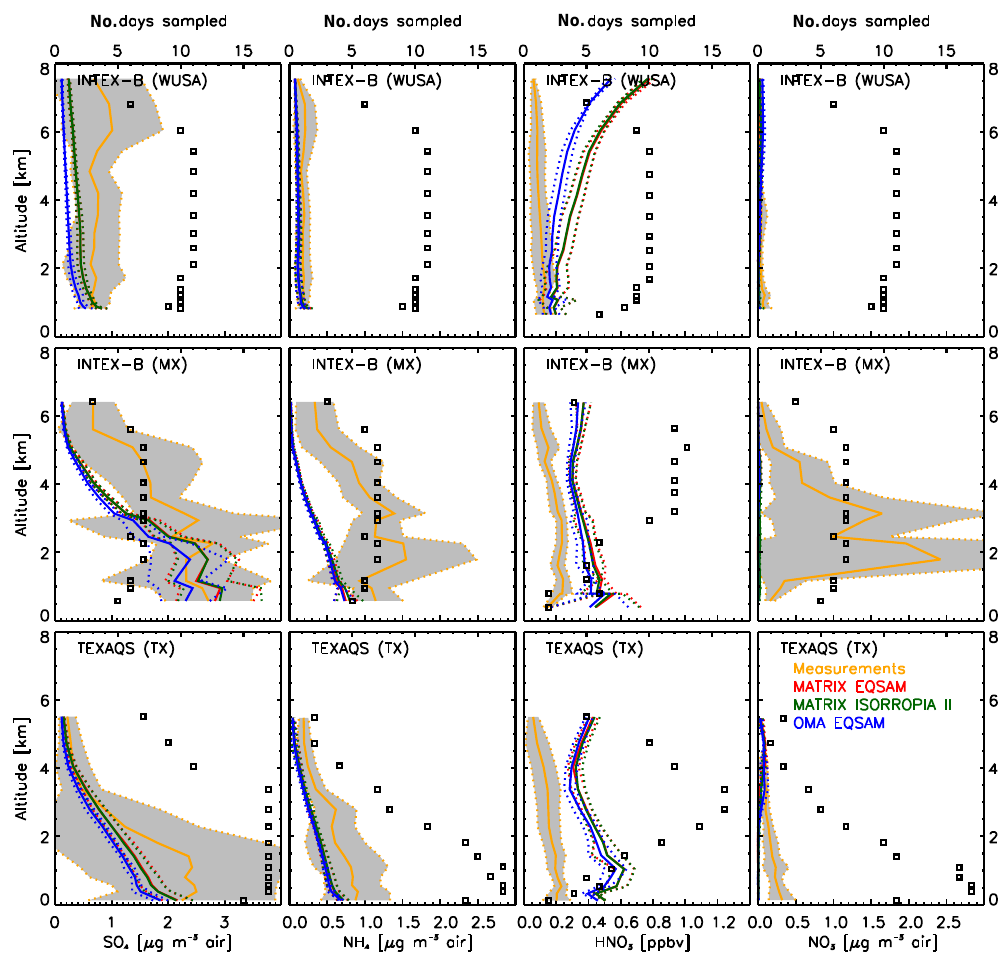
Figure A2. Mean regional concentration profiles. First column is SO 4 , second is NH 4 , third is HNO 3 , and fourth is NO 3 . Measurements are in orange, MATRIX-EQSAM is in red, MATRIX-ISORROPIA II is in green, and OMA-EQSAM is in